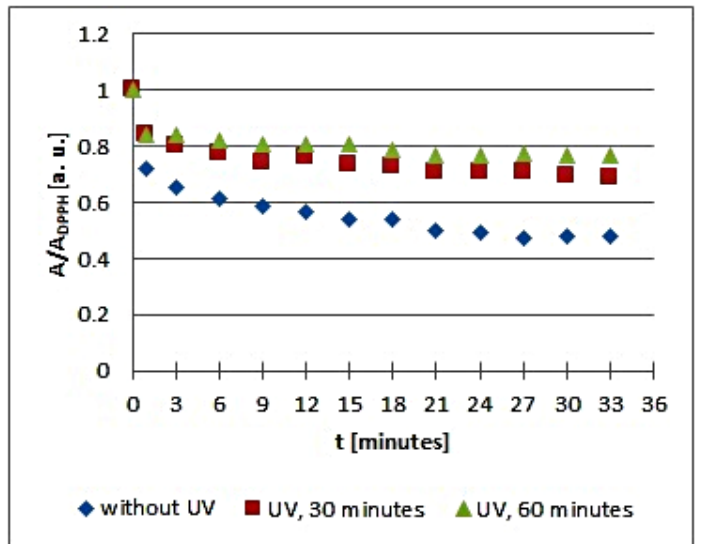
Figure 7. Changes of the relative amplitude (A/A DPPH ) of EPR spectra of DPPH free radicals with increasing time of interactions ( t ) with infusions of Cnicus benedictus L. herb. A—amplitude of the EPR line of DPPH free radicals in contact with the tested samples. A DPPH —amplitude of the EPR line of DPPH free radicals in the reference solution. For the reference solution, the relative amplitude (A/A DPPH ) takes a value of 1. Data for the infusions obtained from the plant materials exposed to UVA radiation for 30 and 60 min are presented. For comparison, data for the infusions of the plant material that was not exposed to UVA radiation are also given.